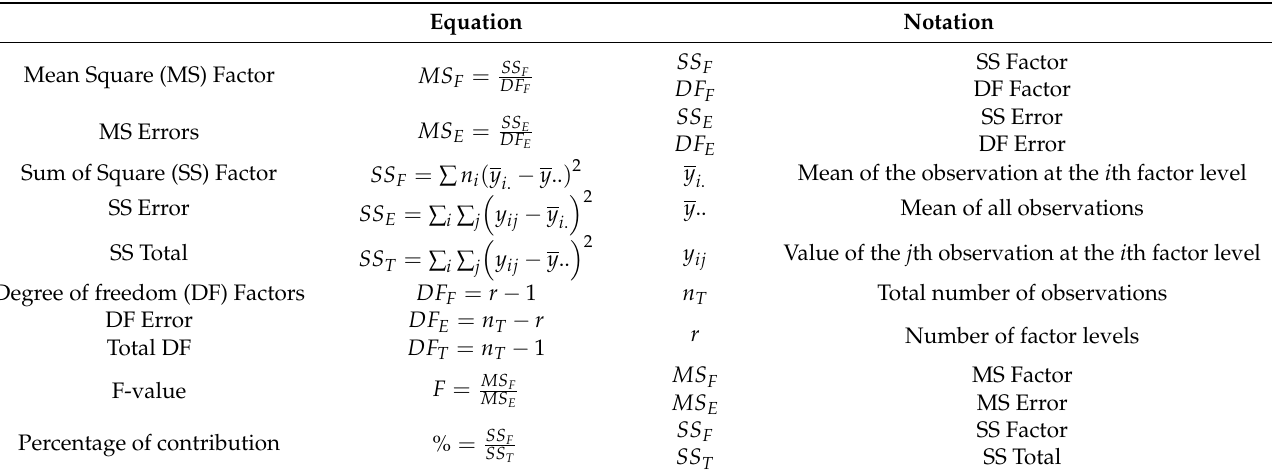
Table 8. ANOVA related